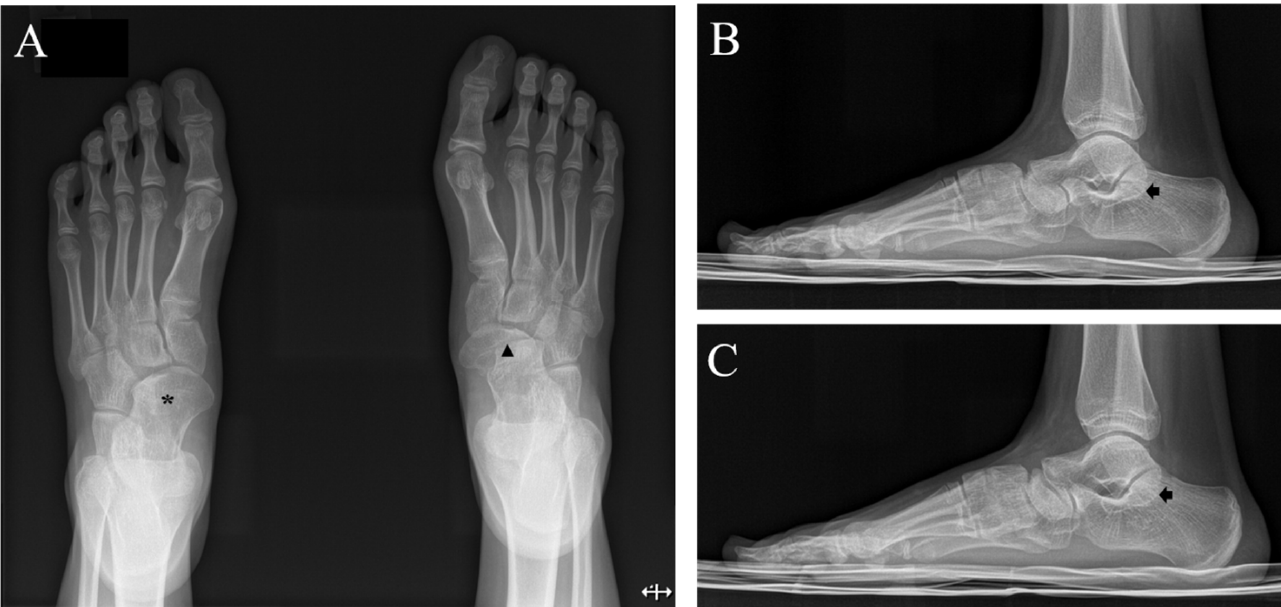
Figure 1. Anteroposterior and lateral radiographs of both feet. ( A ) Anteroposterior radiographs reveal talonavicular coalitions in both feet. The talonavicular coalition was a synostosis (asterisk) in the right foot and a synchondrosis or syndesmosis (arrow head) in the left foot. ( B ) Lateral radiograph shows C-shaped configuration (arrow) of the talocalcaneal coalition at the posterior subtalar joint of the right foot. ( C ) Lateral radiograph shows C-shaped configuration (arrow) of the talocalcaneal coalition at the posterior subtalar joint of the left foot.